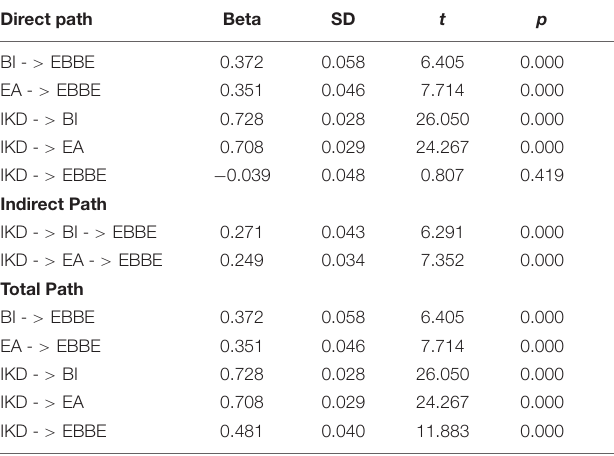
TABLE 5 | Direct, indirect, and total path estimates.